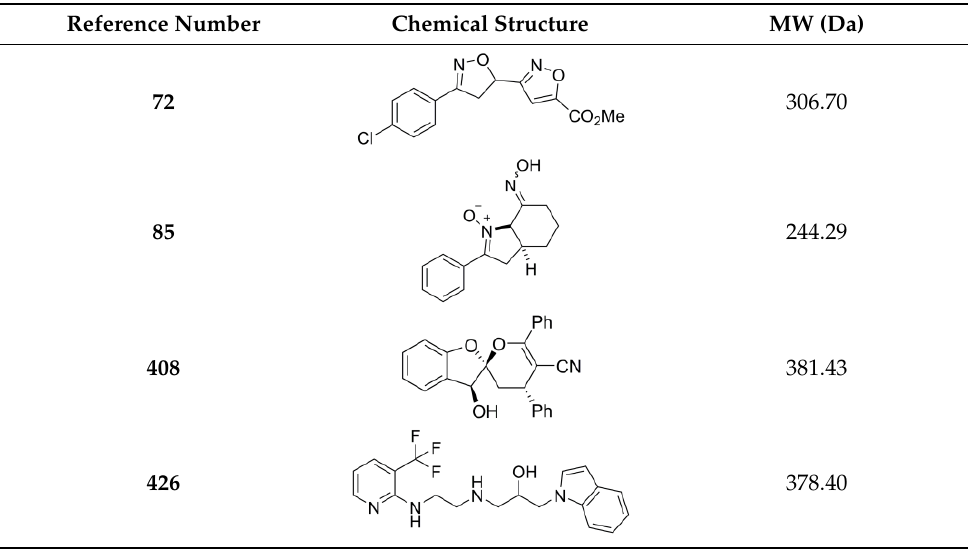
Table 1. Detailed information of four candidatesfrom the compound bank.